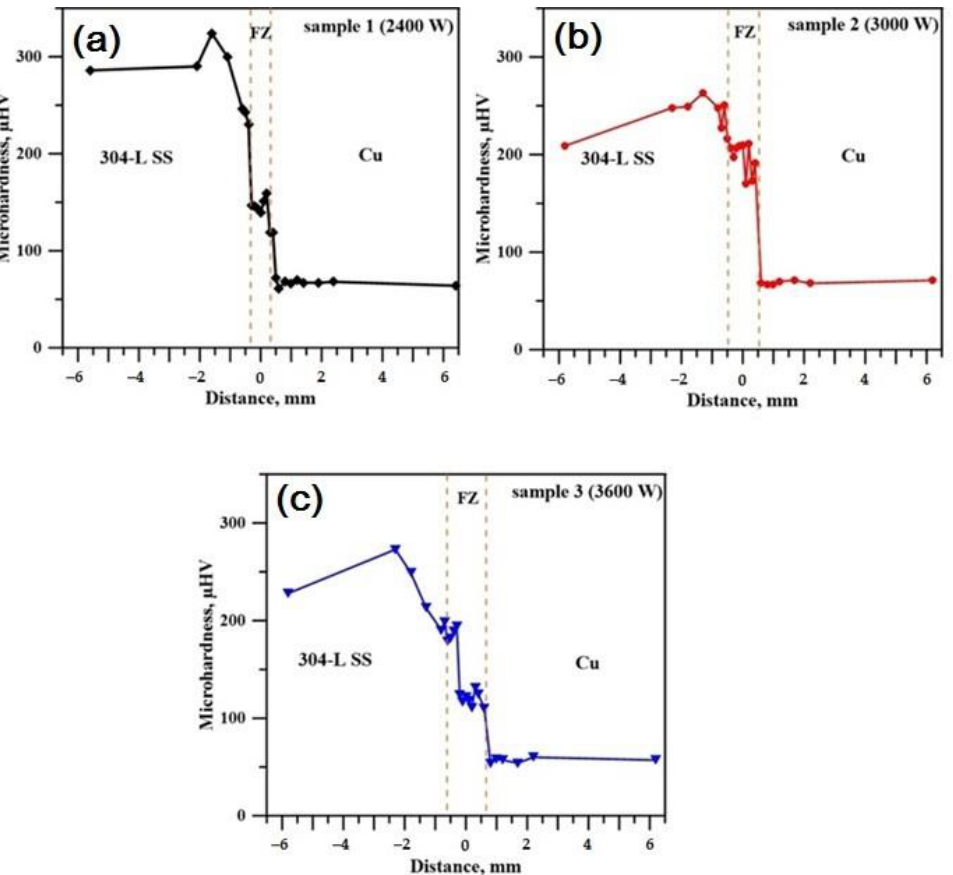
Figure 7. Distributions of the microhardnesses in the middles of the lengths of the welds obtained by: ( a ) 2400 W, ( b ) 3000 W, and ( c ) 3600 W.